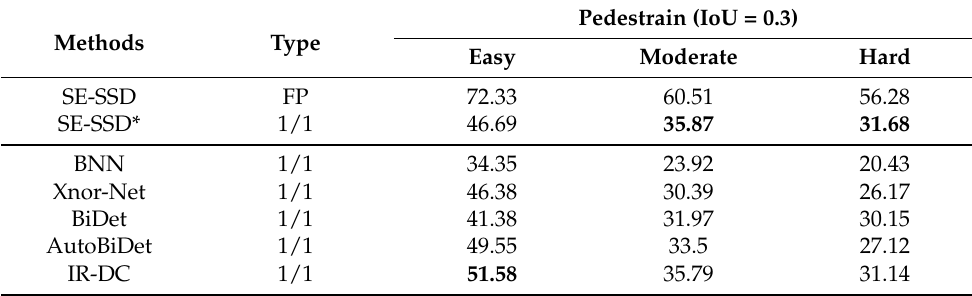
Table 6. Results of pedestrian class in